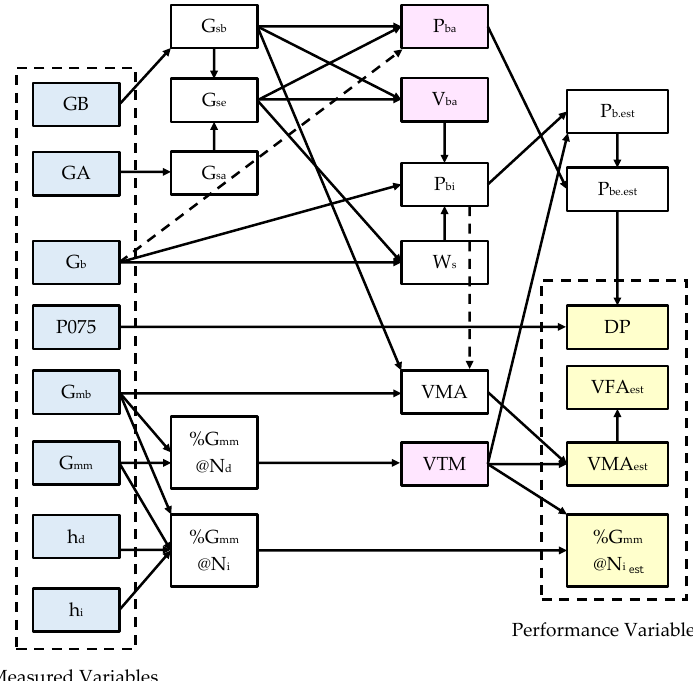
Figure 2. Mathematical paths of the variables involved in the performance evaluation of superior performing asphalt pavement (Superpave) design aggregate structure